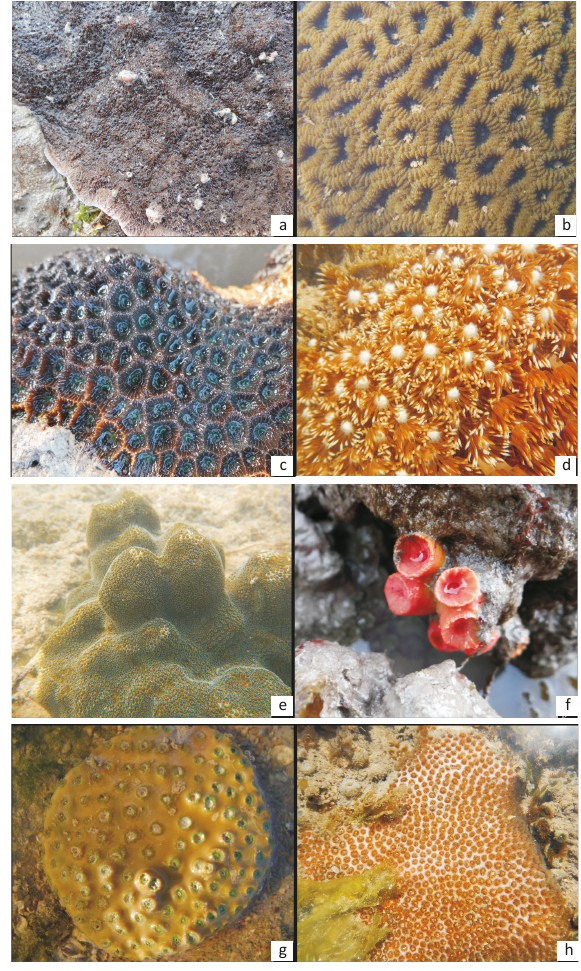
Image 3. Coral species observed from Kuchdi-Porbandar area a - Montipora foliosa ; b - Favia favus ; c - Favites sp.; d - Goniopora minor ; e - Porites lutea ; f - Tubastrea aurea ; g - Turbinaria peltata ; h - Pseudosiderastrea tayami. © Dishant